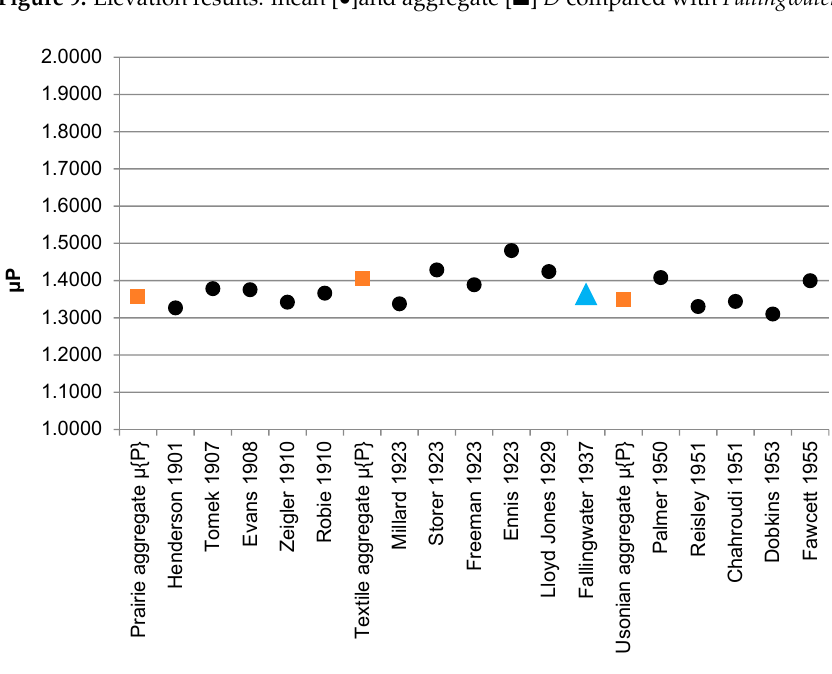
Figure 9. Elevation results: mean [ • ]and aggregate [ (cid:4) ] D compared with Fallingwater [ (cid:78) ].